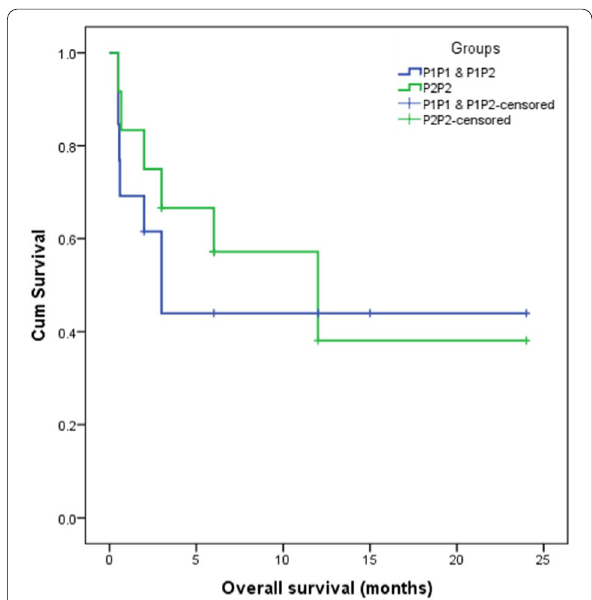
Fig. 1 Kaplan–Meier curves of OS of patients with P2P2 (38.1%) (green line) and patients with P1P1 and P1P2 (44.40%) (blue line) after 12 months of